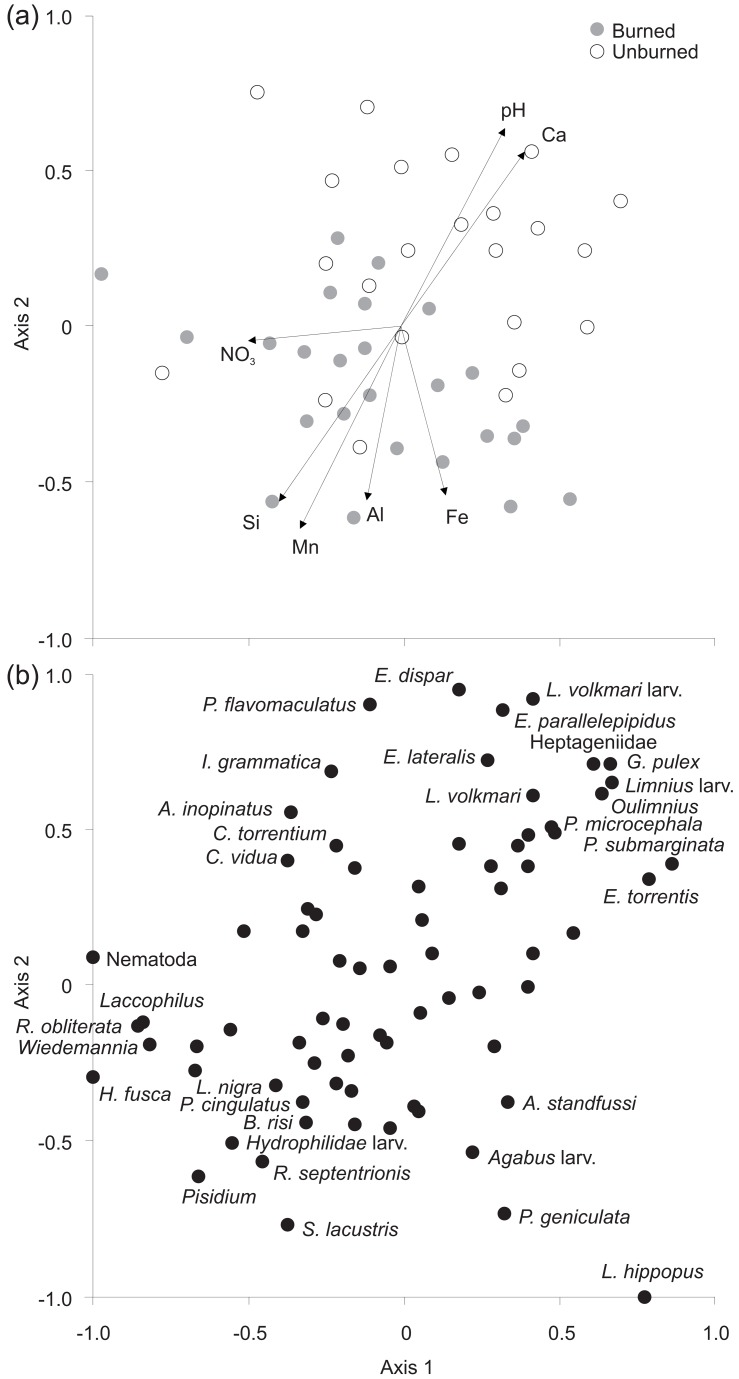
(a) NMDS biplot of samples and significantly correlated environmental variable vectors (pH: R2=0.43, p=0.001; NO3: R2=0.20, p=0.014; Al: R2=0.27, p=0.001; Ca: R2 = 0.39, p=0.001; Fe: R2=0.27, p=0.003; Mn: R2=0.46, p=0.001; Si: R2=0.42, p=0.001), and (b) taxa.